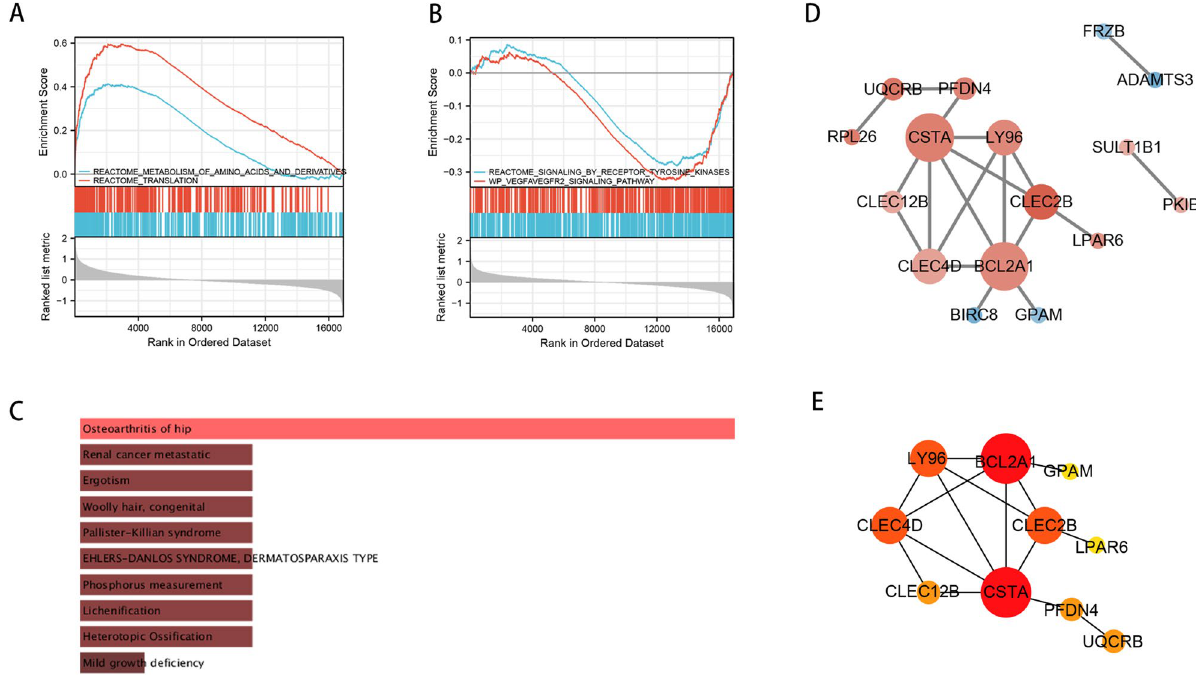
Figure 3. Enrichment analysis and PPI network construction of overlapped DEGs. ( A ) GSEA results of PsA and CL group; ( B ) GSEA results of PsA and PsC group; ( C ) Disease Ontology (DO) analysis of overlapped DEGs. ( D ) PPI network of overlapped DEGs. Red and blue circles represented up- and down-regulated genes, respectively. The edge color and width are proportional to the combined score analyzed by STRING. ( E ) The top 10 hub genes are determined by cytoHubba.